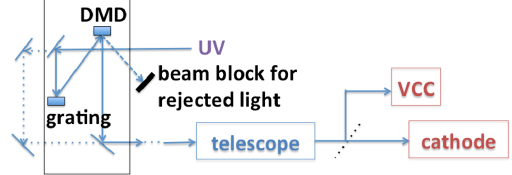
FIG. 1. Simplified layout of the LCLS injector laser imaging system with the DMD and grating